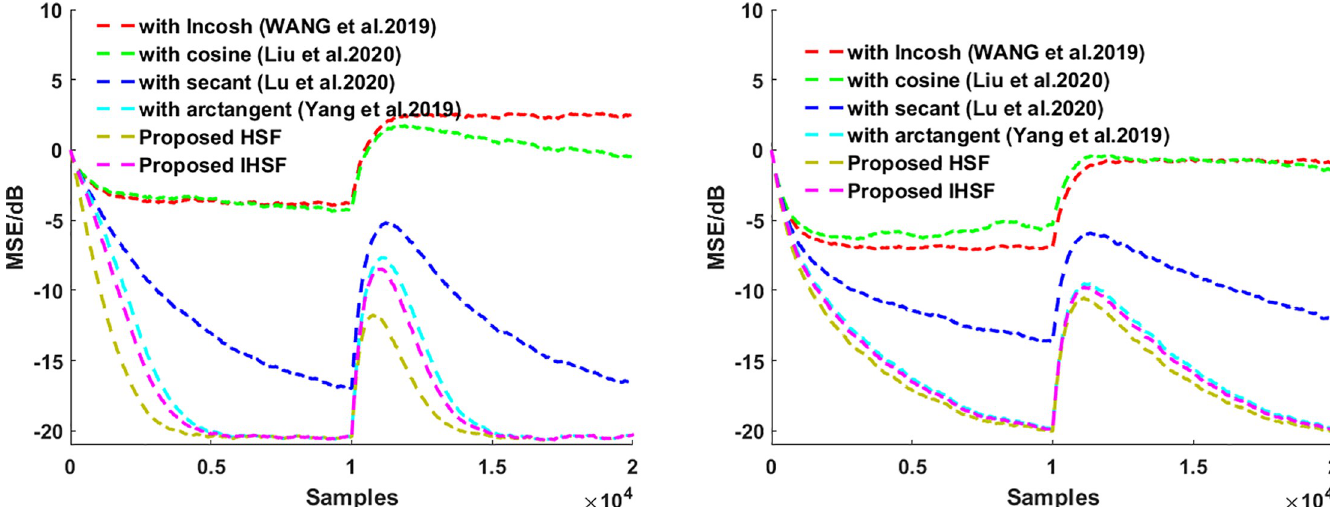
Fig 2. MSEs for the adaptive filtering algorithms by using hyperbolic functions. (left) with the uncorrelated input signal X UC ( n ); (right) with the correlated input signal X C ( n ).